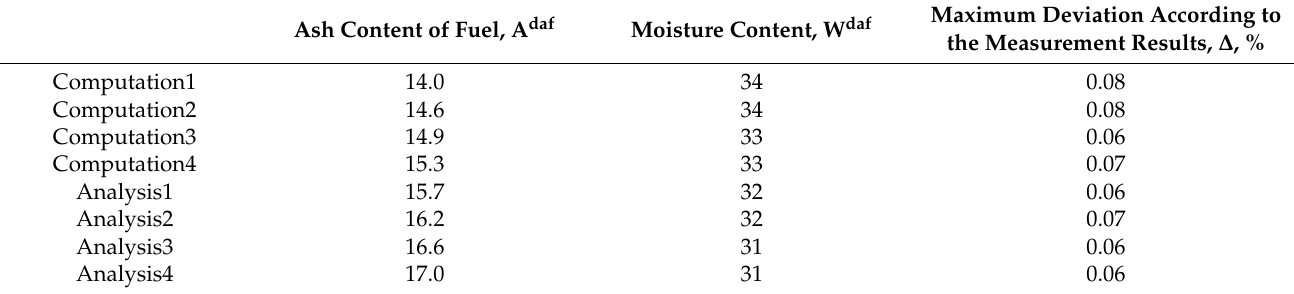
Table 4. Results of direct measurements and